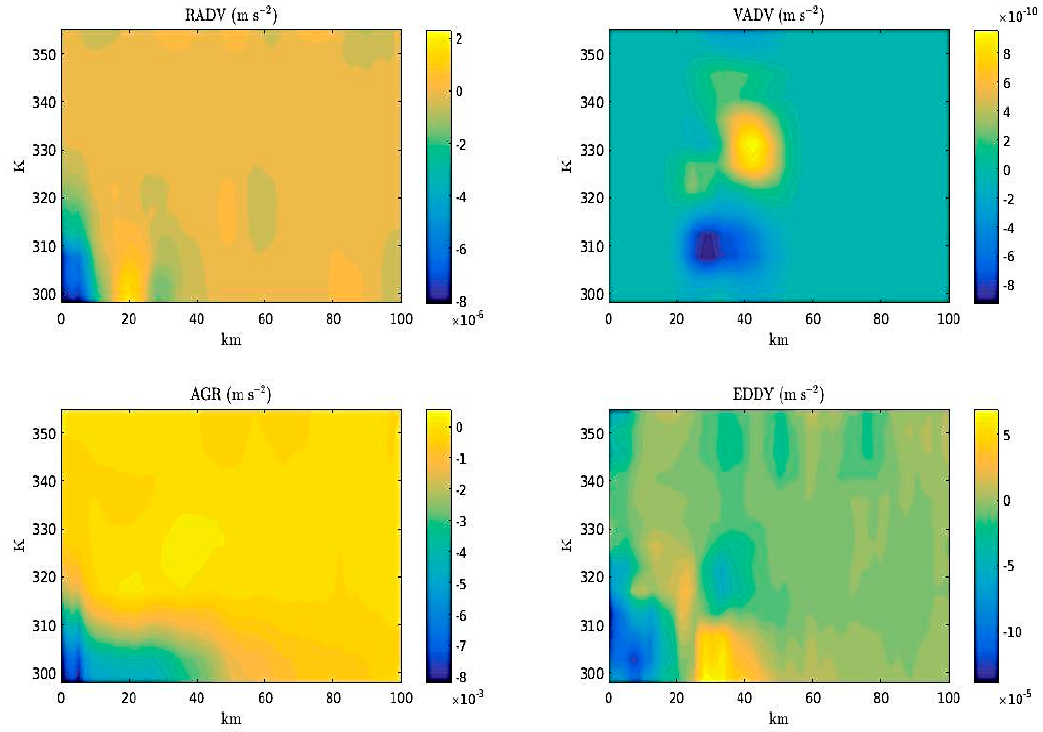
Figure 12. Same as Figure 10, except from (cid:1872) = 36